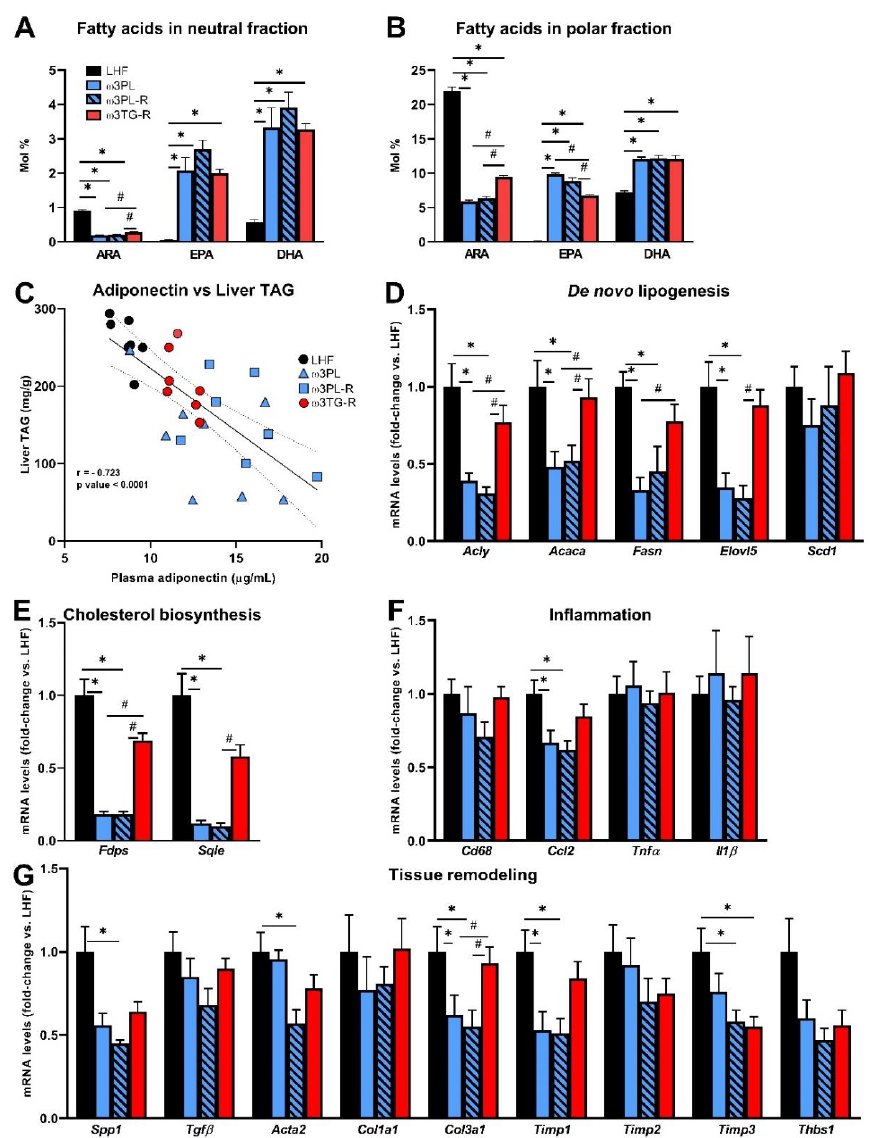
Figure 5. Selected parameters determining the effects of omega-3 PUFAs in the liver: bioavailability of FAs such as arachidonic acid (ARA), eicosapentaenoic acid (EPA) and docosahexaenoic acid (DHA) measured in the neutral ( A ) and polar ( B ) fraction of liver lipids; correlation between plasma adiponectin levels and the degree of TAG accumulation in the liver ( C ); hepatic expression of genes related to DNL ( D ), cholesterol biosynthesis ( E ), inflammation ( F ), and tissue remodeling ( G ). Data are means ± SEM ( n = 7–8). *, significant effect of omega-3 PUFAs (vs. LHF); #, significant difference from ω3TG- R (one-way ANOVA or Kruskal–Wallis).